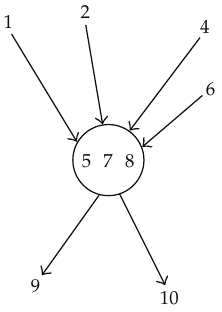
Figure 3: Level two Bayesian network on S